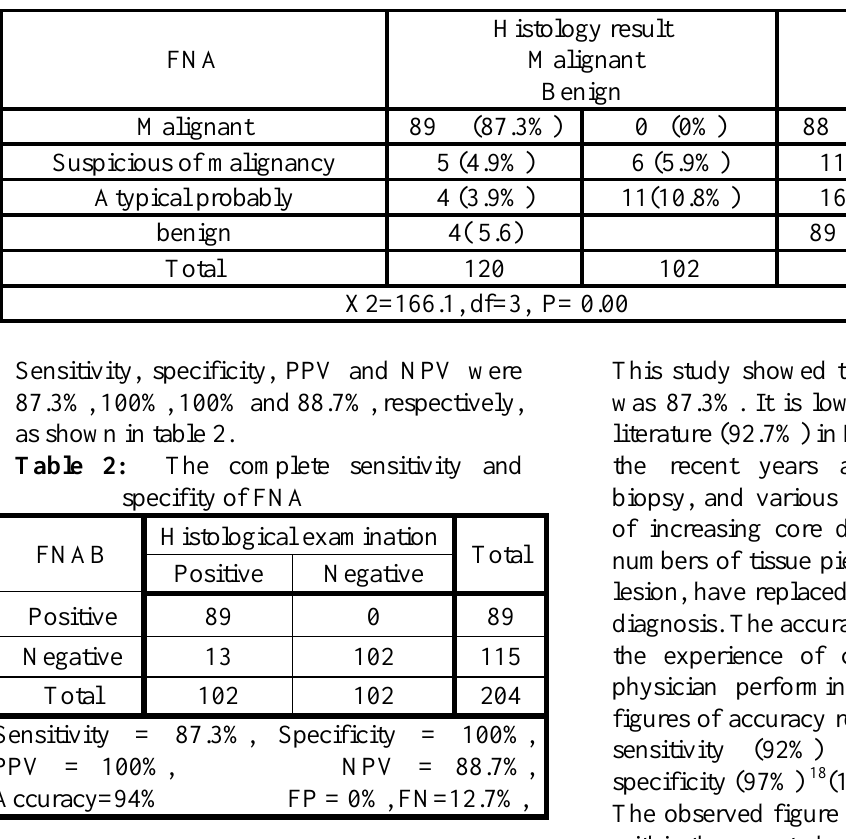
Table 1: The histological (reference) and FNAB (index) tests result presentation